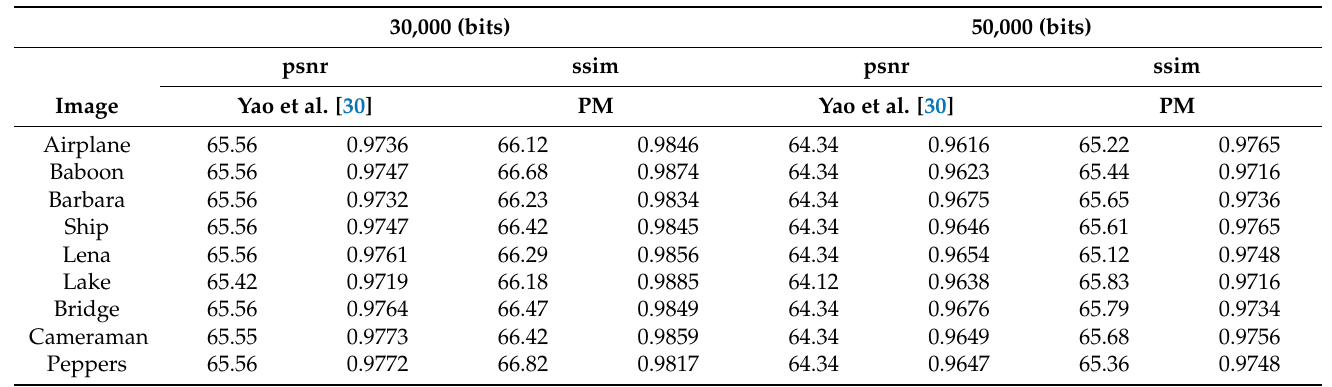
Table 8. Compares the PSNR value for the PM and yao et al. [22]